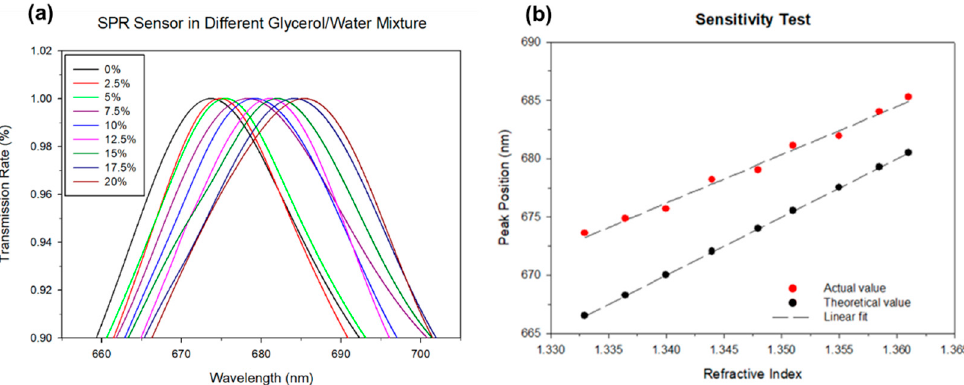
Figure 5. Sensitivity test. ( a ) Peak values of different volume ratios of glycerol to water solutions. ( b ) The peak value of the resonant spectrum versus the refractive index compared to theoretical values.